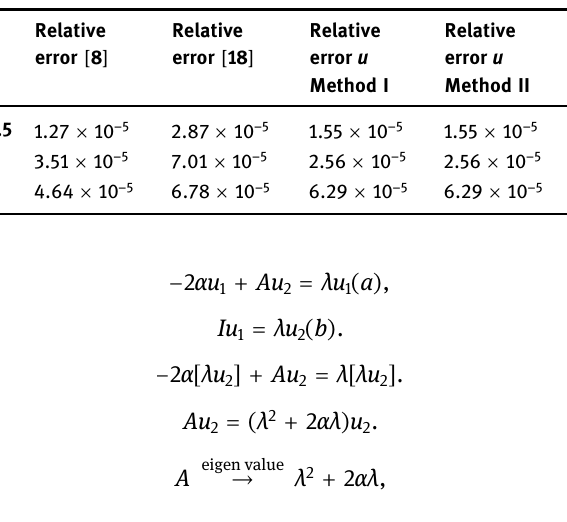
Table 20: Comparison of errors for = α 50 , = β 5 , = N 21 ,